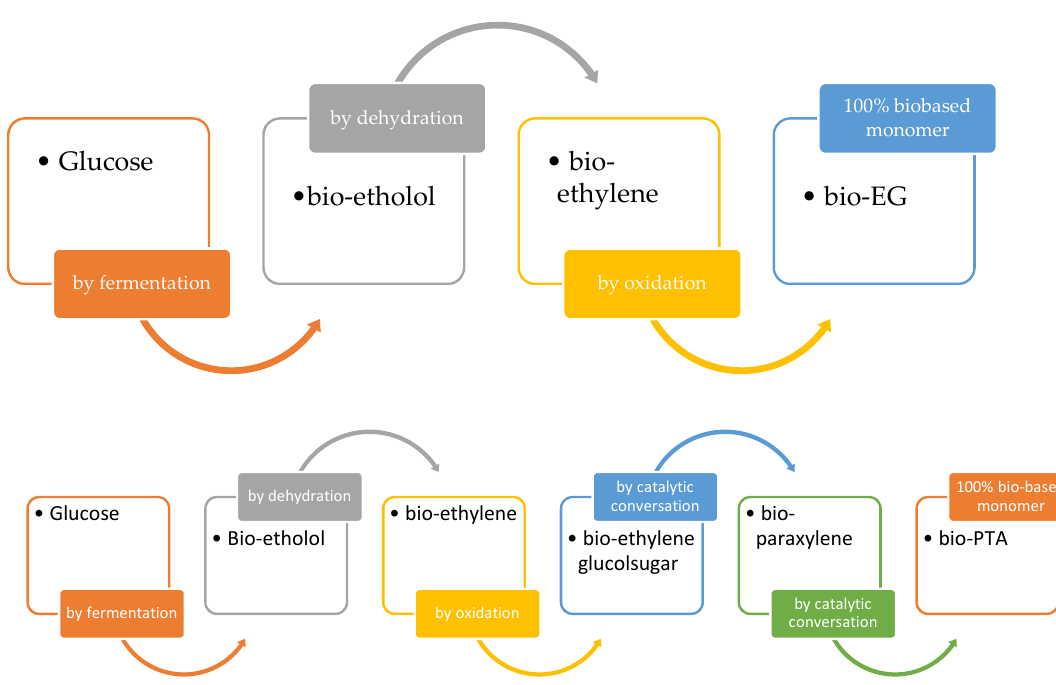
Figure 9. General scheme for Bio-EG and Bio-PTA monomers